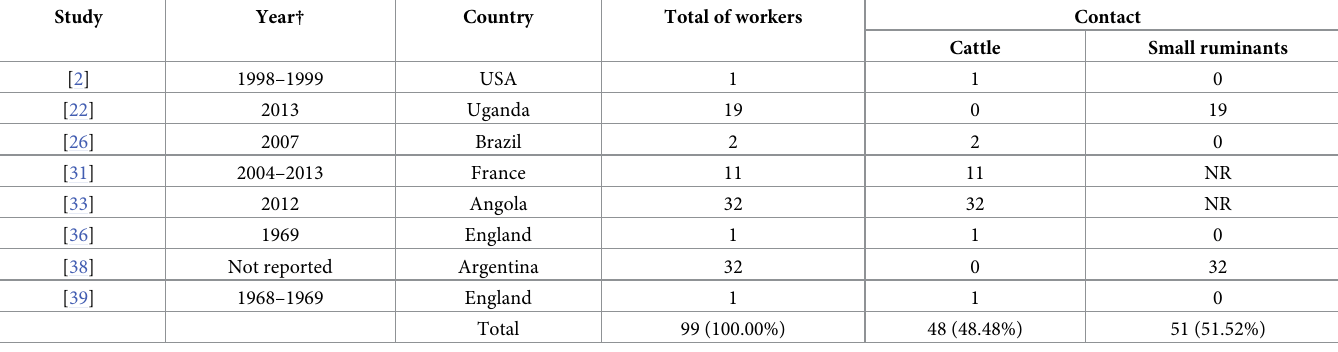
Table 1. Farm animal species related to occupational brucellosis transmission among infected rural workers.